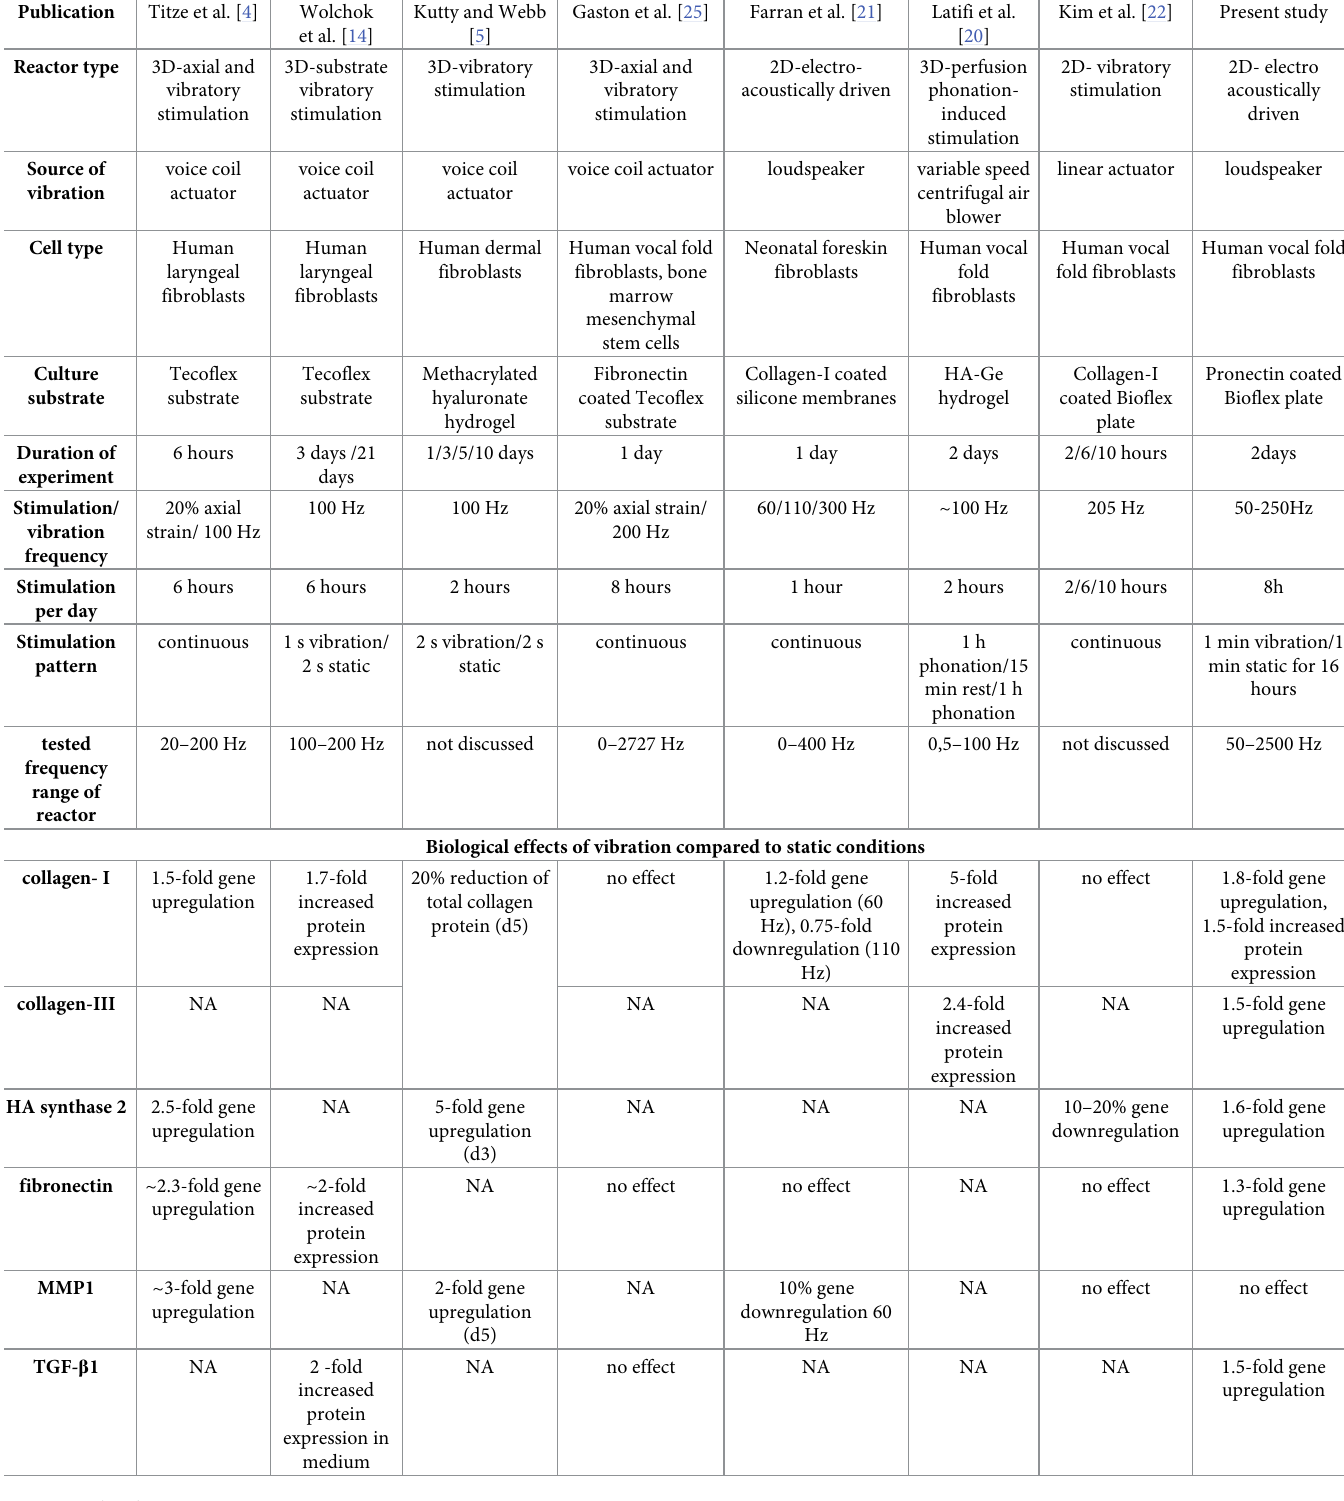
Table 3. Summary table of the vocal fold bioreactors cited in the